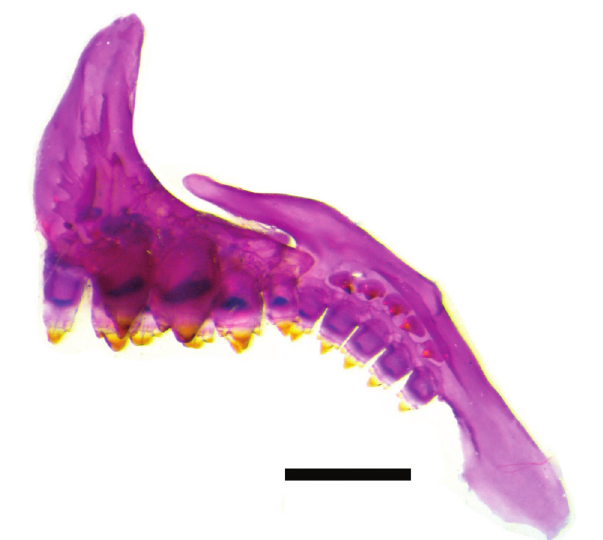
Fig. 4. Premaxilla and maxilla of Carlastyanax aurocaudatus , CI-FML 5015, 44.4 mm SL, medial view, anterior to left. Scale bar = 1 mm.